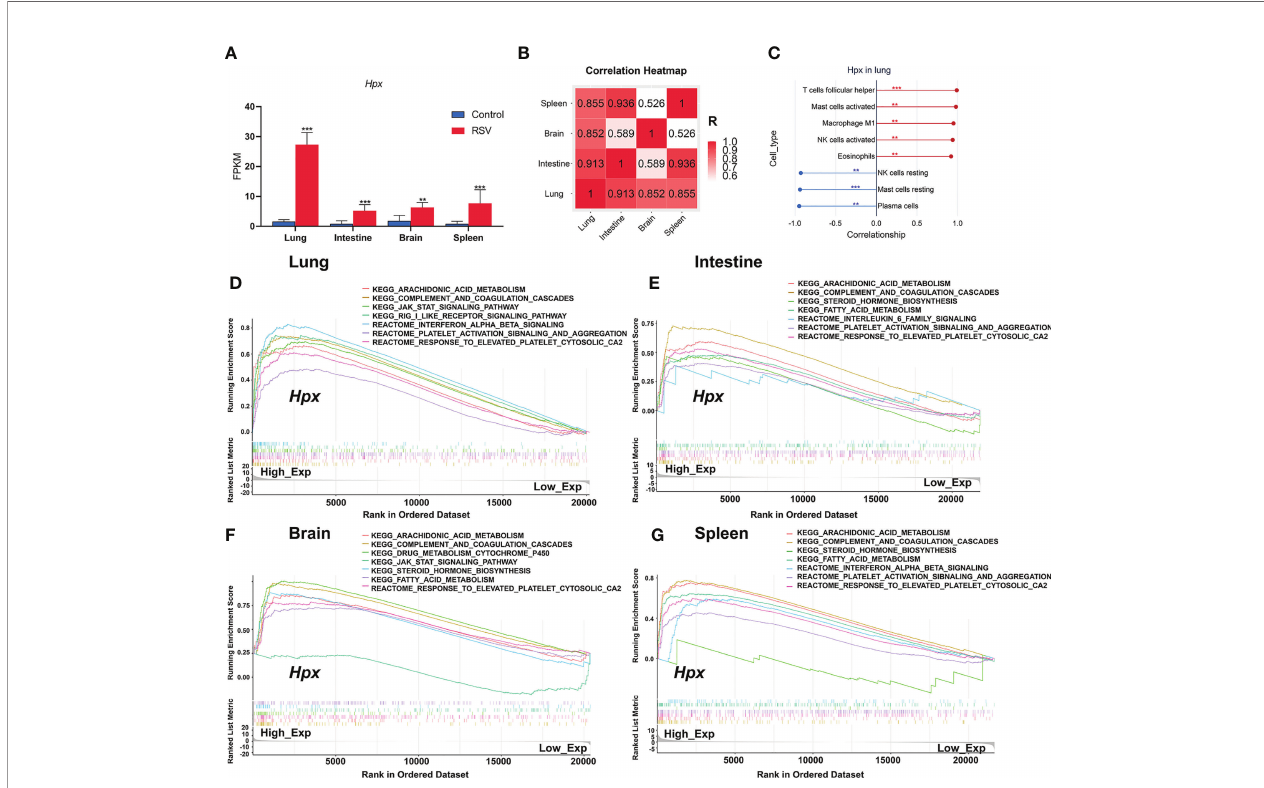
FIGURE 6 | Correlation between immune cells and Hpx expression and pathways associated with Hpx alteration predicted by GSEA. (A) Hpx expression in transcriptome results. (B) Hpx expression correlation heatmap in four organs. (C) Scatter diagrams from correlation analysis in lung. Y-axis represents Hpx, x-axis represents immune cell content, as de fi ned by CIBERSORT algorithm. (D) Predicted pathways in lung, (E) intestine, (F) brain, (G) and spleen. Comparative changes between high- and low-expression groups. All terms shown are signi fi cantly enriched at NES> 1 and p < 0.05. ** p < 0.01, *** p < 0.001, number of asterisks represent degree of